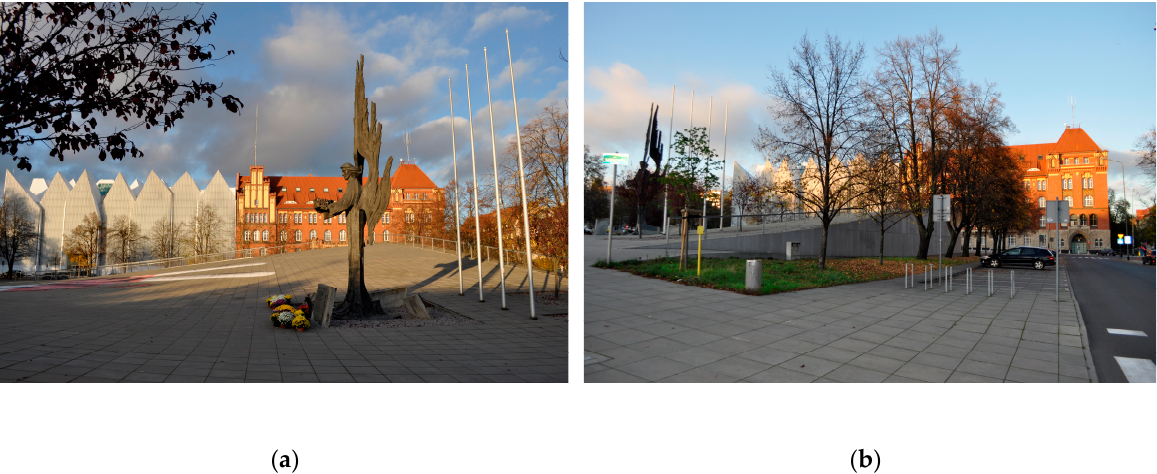
Figure 5. Plac Solidarno´sci in Szczecin. The square was built on the site of a former residential quarter, which was demolished during World War II. As a place of workers’ protests, it became a symbolic space—a place of lieux de mémoire , initiating the process of emancipation and of building the ‘identity of the citizen of Szczecin’: ( a ) Monument to the December 1970 Victims (source: created by author); ( b ) the Dialogue Centre ‘Upheavals’ (DCU), view from ul. Tadeusza Mazowieckiego (source: created by author).